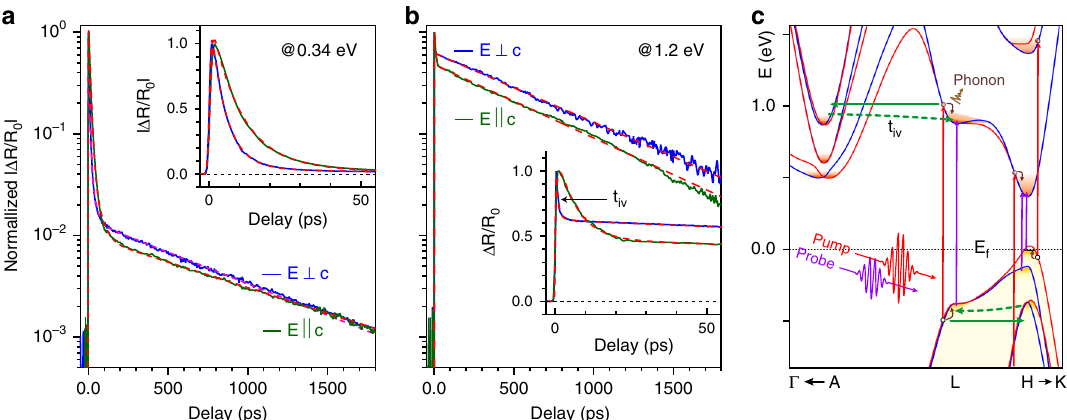
Fig. 5 Polarization and energy-dependent carrier decay dynamics. Representative polarization-resolved TR ( Δ R / R 0 ) traces of Te samples around the fundamental gap a and higher energy transition region b . Dashed red lines are the multi-exponential fi ts of each corresponding data over a long delay range, as described in the main text. Insets show the initial decay responses of each corresponding trace. Around the band-edge region, a majority of the TR signal relaxes within fi rst 30 ps due to ultrafast intraband thermalization followed by interband recombination. Around the higher energy transition, only a fraction of the maximum TR signal decays rapidly, predominantly by intervalley scattering accompanied by intraband thermalization, while the rest of the signal recovers on the order of a nanosecond due to interband recombination. c Schematic drawing of carrier excitation and relaxation processes within the extended bulk band structure of Te around high symmetry points in the Brillouin zone. Pump excitation is indicated by vertical red arrows and probe excitation is shown by vertical purple arrows. Intervalley forward and return scattering processes are also shown by green solid and dashed